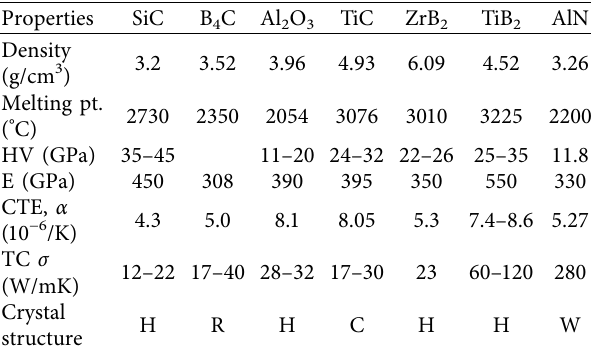
Table 4: Physicomechanical properties of hard particulate rein- forcements used for AMC and HAMCs development [66,